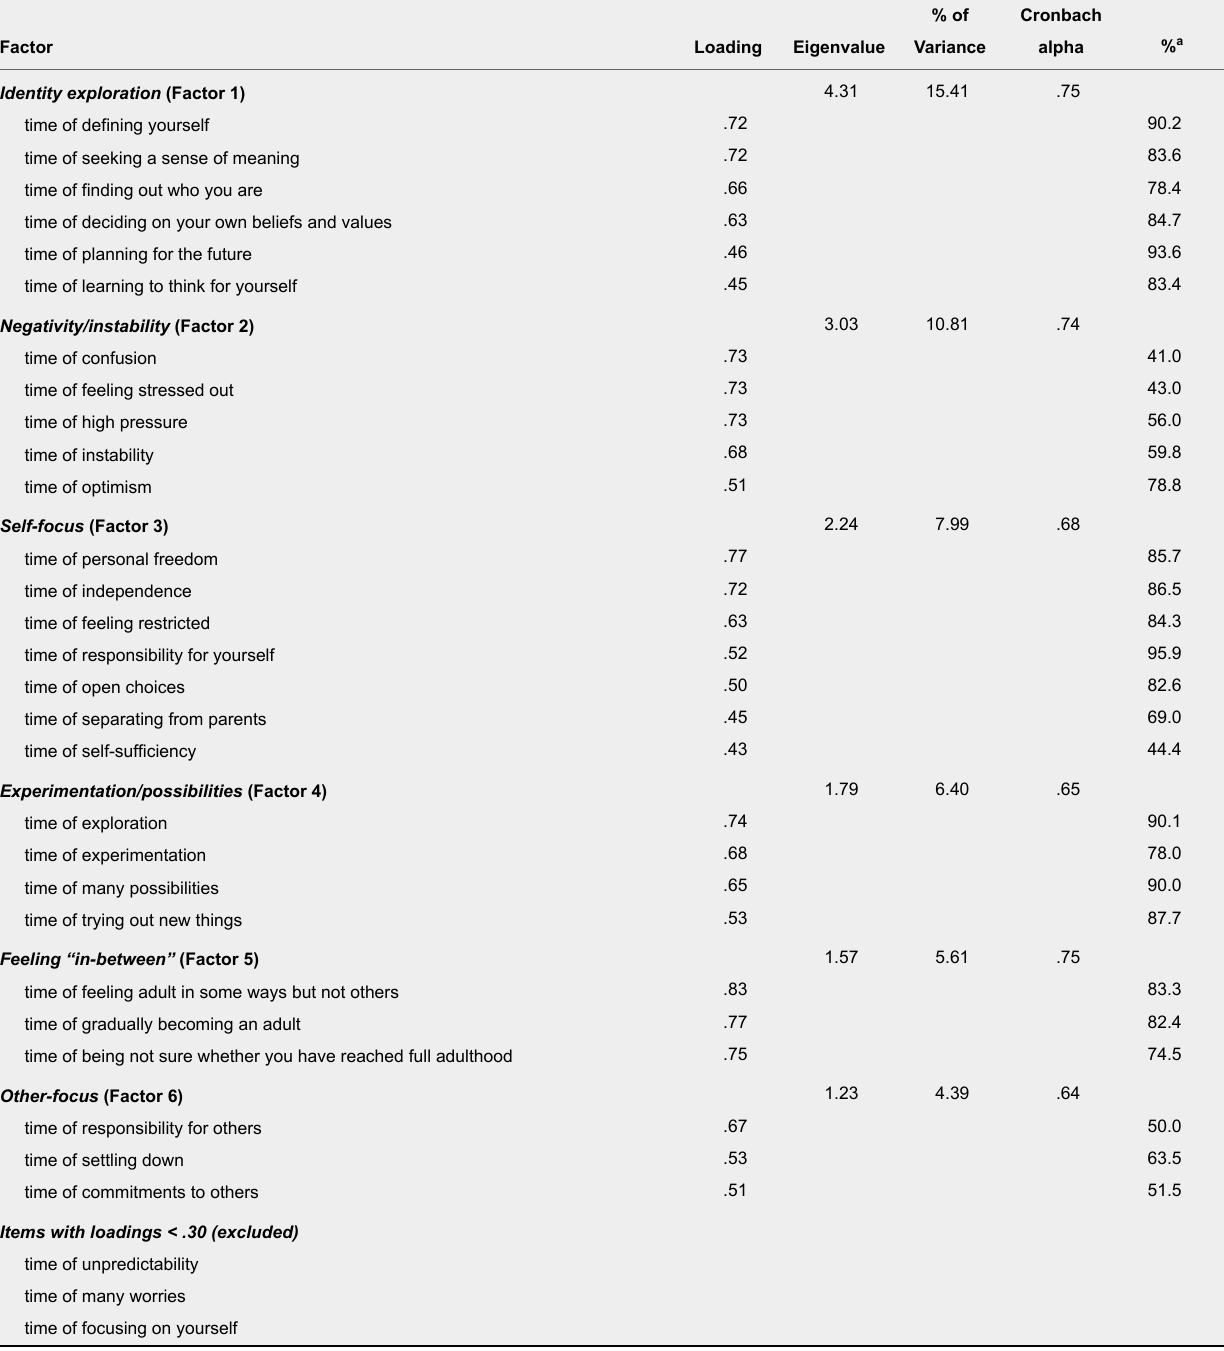
Exploratory Factor Analysis and Endorsement of the Developmental Features of Emerging